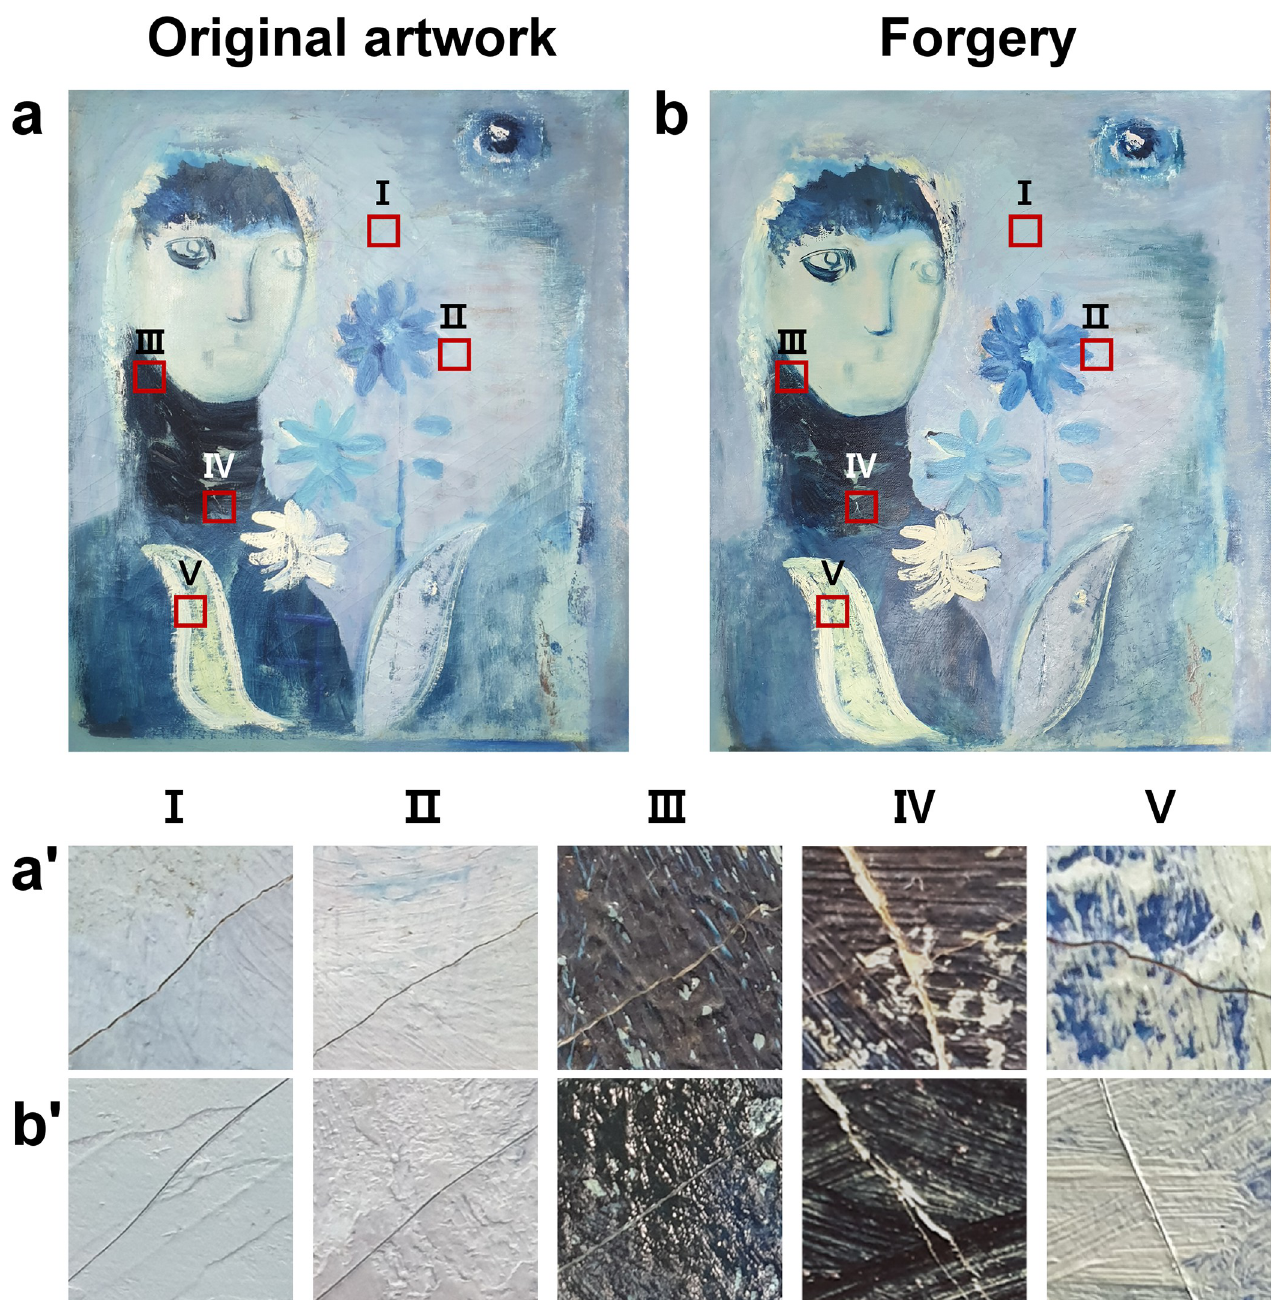
Fig 5. Images showing the location of cracks in (a) the original and (b) forged oil paintings. The enlarged images of cracks selected as the OCT measurement area in (a’) the original artwork and (b’) the forged artwork. In various areas of this artwork, cracks were created by ( Ⅰ , Ⅱ ) canvas aging, ( Ⅲ , Ⅴ ) paint layer drying, and ( Ⅳ ) physical impact on the layer. The forged cracks were created considering the characteristics and causes of the original cracks. tools were used to perform finely tuned slashing to create long paths of dynamic cracks in the painting layer of the forged work (Fig 6B’ Ⅰ ) . Consequently, forged cracks with thicknesses and directions similar to those of the original cracks were created.